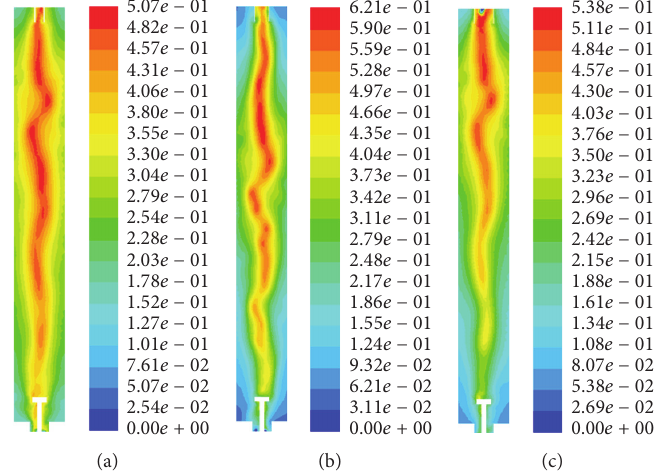
Figure 8: The volume fraction of gas with different gas phase outlet diameters: (a) 𝑟 𝑔 = 8 mm; (b) 𝑟 𝑔 = 13mm; (c) 𝑟 𝑔 = 18 mm.